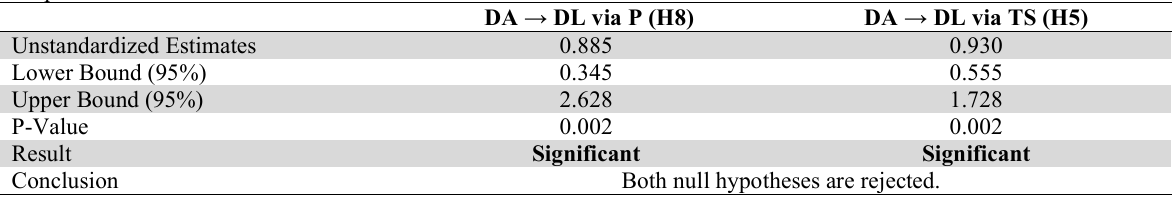
Comparison Results between P and TS Unstandardized